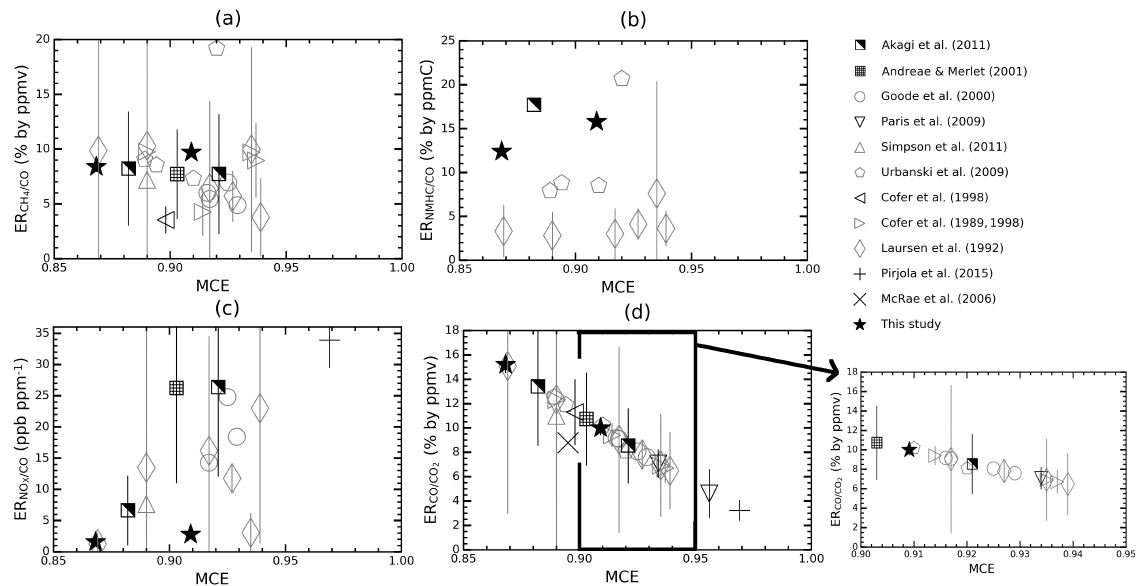
Figure 7. Scatter plots of trace gas ER Y /X with standard uncertainties (where available) versus MCE for this study and previous publications.